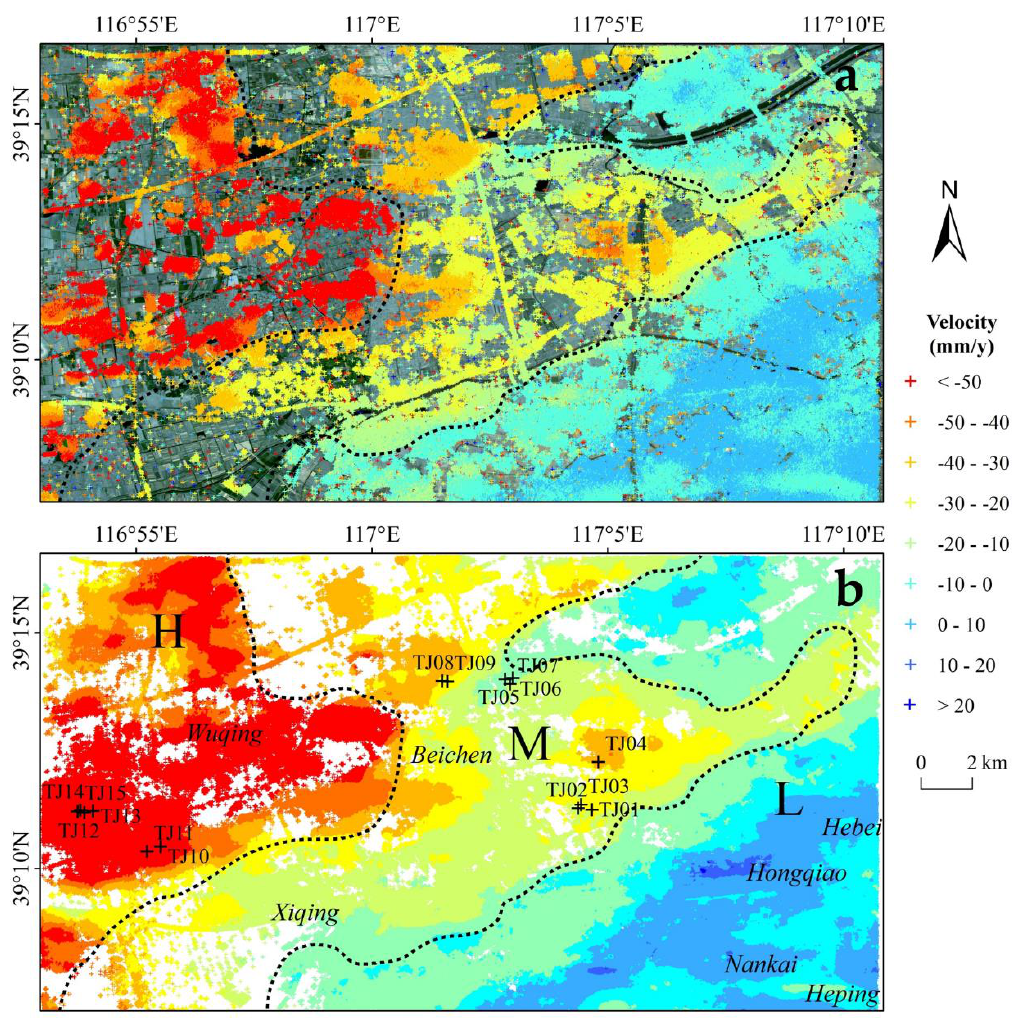
Figure 4. Annual line of sight (LOS) mean subsidence velocity map from March 2017 to March 2019 from ( a ) PS-InSAR and ( b ) SBAS-InSAR data. The deformation value is displayed with different colors. H stands for the high subsidence area, M means the medium subsidence and L for low subsidence area. The PS results are superimposed on the Sentinel-2A images and field investigation points (TJ01-TJ15) are shown in (b).